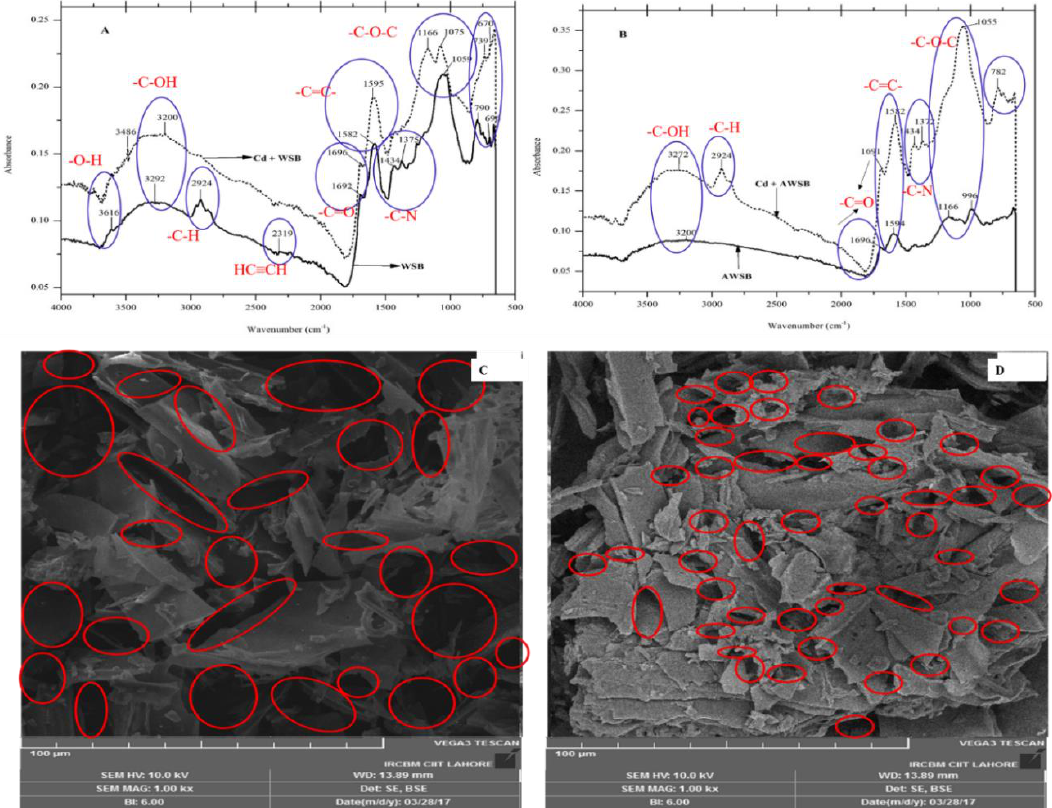
Figure 2. Fourier Transform Infrared (FTIR) spectra of Cd loaded and unloaded wheat straw biochar (WSB, ( A )) and acid activated wheat straw biochar (AWSB, ( B )); Scanning electron microscopy (SEM) images of WSB ( C ) and AWSB ( D ).